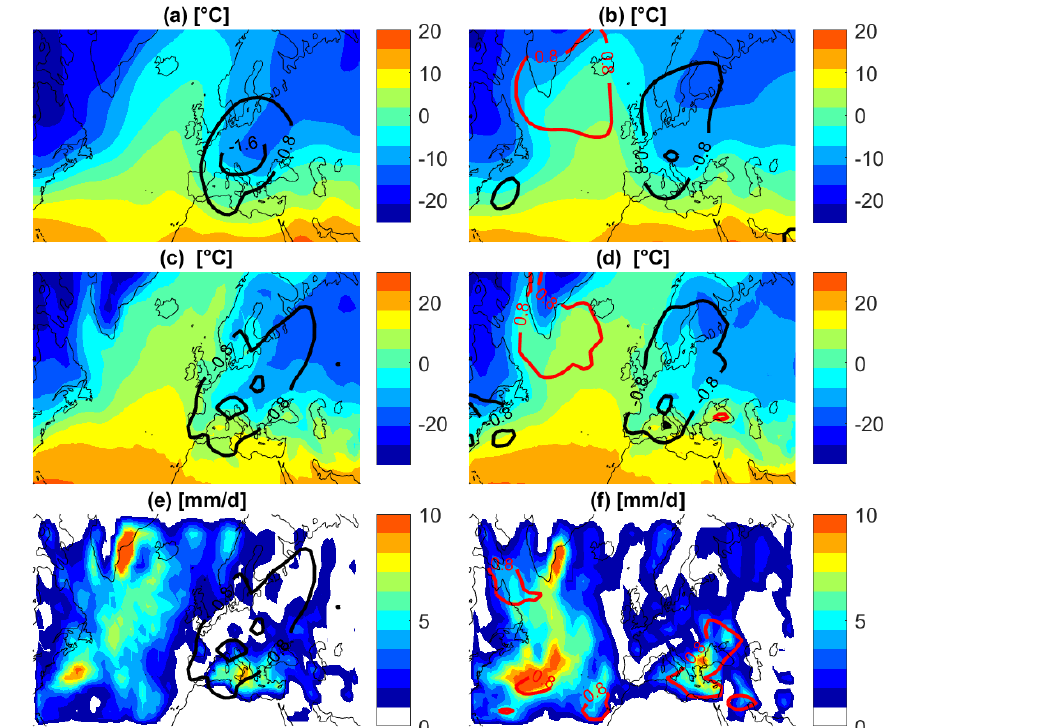
Figure 3. Physics for clusters of cold spells over Italy. Temperature at 850hPa [ ◦ C] (a, b) , 2m temperatures [ ◦ C] (c, d) , and precipitation rate [mmd − 1 ] (e, f) averaged over the two clusters of cold spells in Italy found via k means. In cluster 1 (a, c, e) warm air is advected towards the British Isles and cold air flows mainly from Russia and eastern Europe. In cluster 2 (b, d, f) warm air extends north from the Azores to Iceland and cold air flows south from Scandinavia. The temperature field at the surface is very similar, with cold temperatures over continental areas and negative or very low positive daily values over Italy, especially the peninsular regions. Black and red isolines represent negative and positive standardized